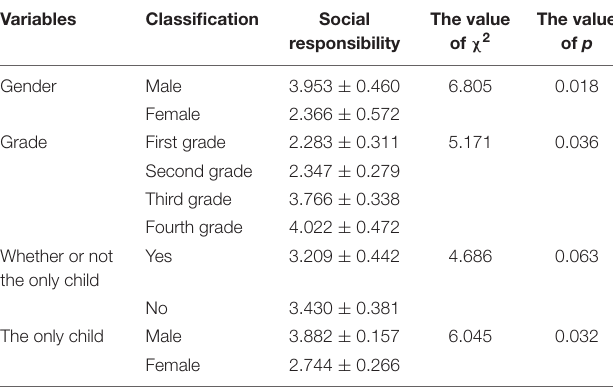
TABLE 6 | An analysis of the difference of social responsibility in general demographic